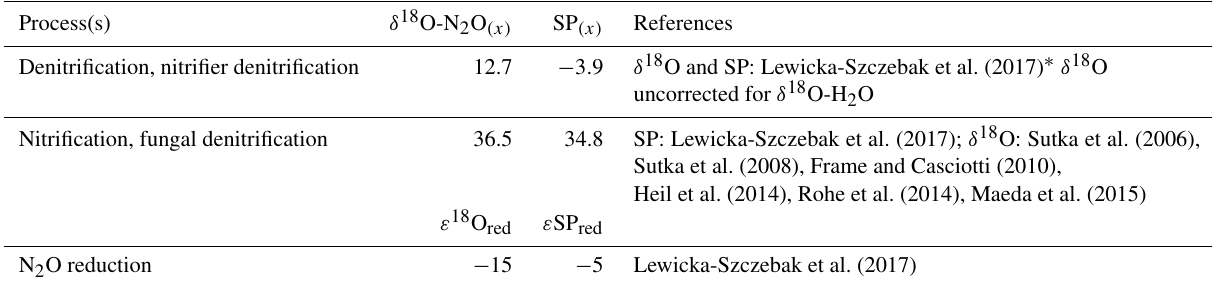
Table 2. End-member values used for modeling of the fraction of residual N 2 O not reduced (gross r N 2 O) and the fraction of N 2 O + N 2 attributed to denitrification (gross frac DEN ) for both open and closed N 2 O reduction fractionation